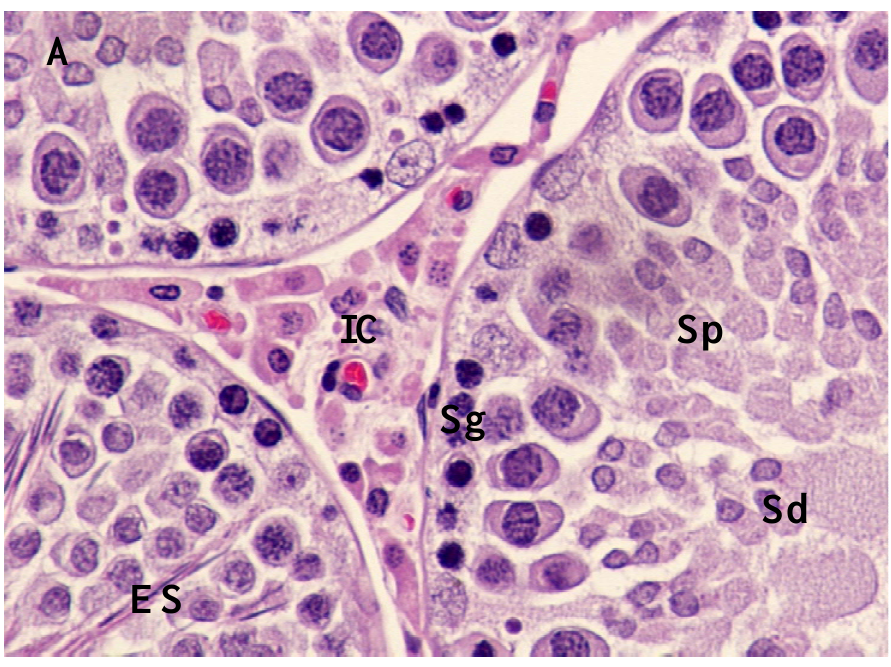
Figure 1. ( A ) Section of the seminiferous tubules of control rat showing normal spermatogenesis with normal features of spermatogonia (Sg), spermatocytes (Sp), spermatids (Sd), elongated spermatids (ES) and interstitial cells (IC) × 1,000. ( B ) Spermatogonia (Sg) rest upon the basal lamina (BL). Both spermatogonia (Sg) and spermatocytes (Sp) appear normal. Mitochondria (M) of germ cells exhibited in abundance with sign of degenerations